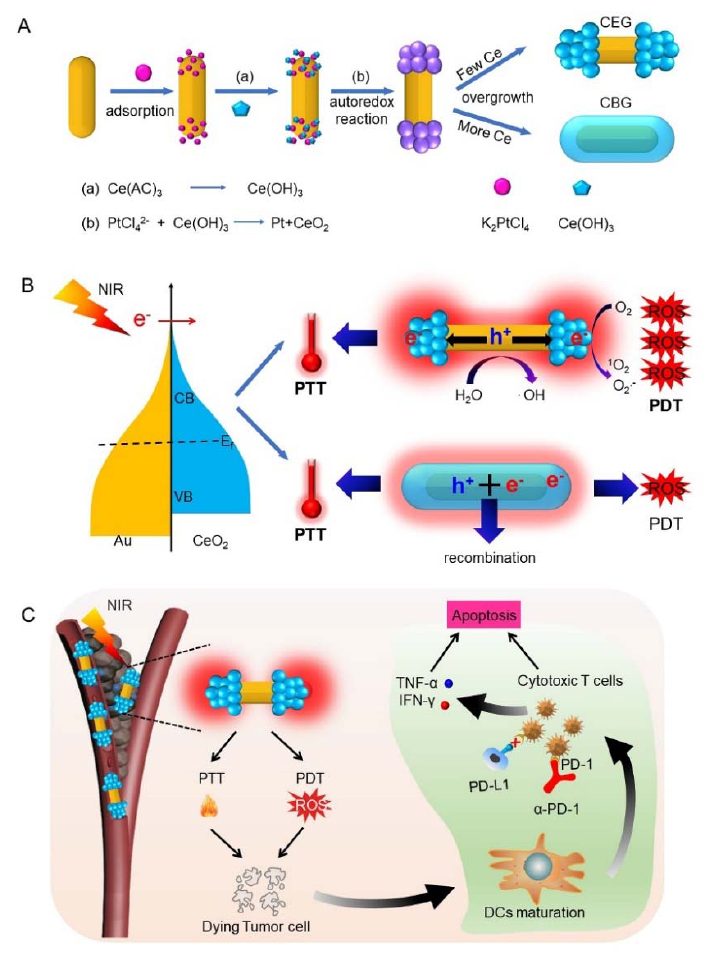
Figure 1. Schematic illustration of the combination therapy of photoimmunotherapy synergizes with PD-1 blockade in triple-negative breast cancer using CEG NRs. ( A ) Illustration of the synthesis process of CEG and CBG [14]. ( B ) NIR laser-activated charge carrier spatial separation to release heat and promote more ROS production for CEG than CBG. ( C ) CEG NRs displayed significant PDT and PTT effects to activate systemic immunity to destroy tumor cells together with α -PD-1 after intravenous administration to breast cancer-bearing mice.